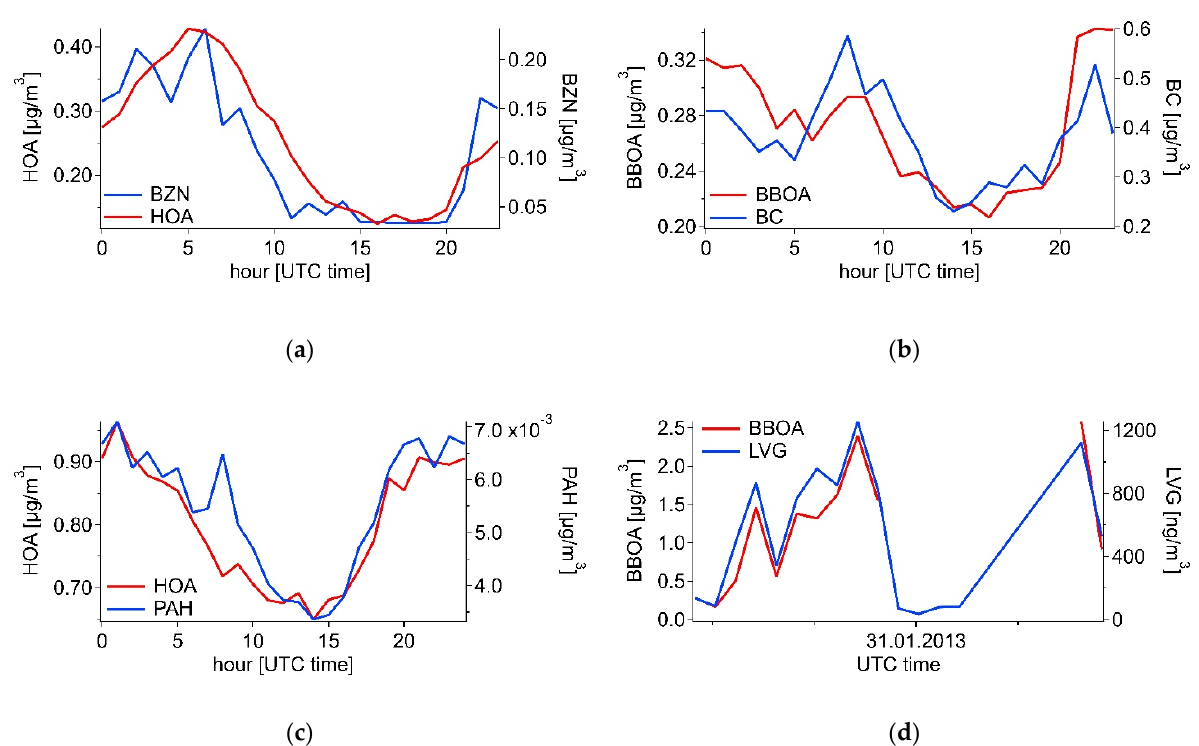
Figure 3. Average diurnal cycles of POA factors and associated measurements: ( a ) summer HOA factor and benzene; ( b ) summer BBOA factor and black carbon; ( c ) winter HOA factor and PAHs; ( d ) time series of two-day averages of winter BBOA factor and levoglucosan.